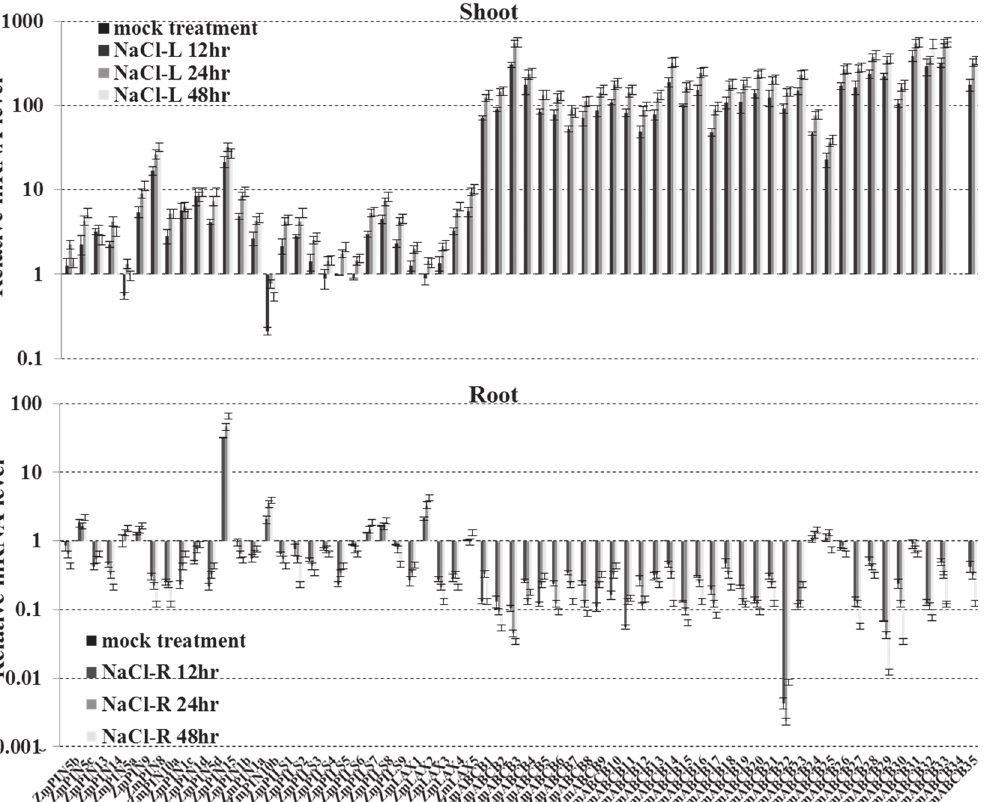
Fig 5. Expression levels of ZmPIN , ZmPILS , ZmLAX and ZmABCB gene families in response to salt. Expression levels of ZmPIN , ZmPILS , ZmLAX and ZmABCB genes were analyzed by qRT-PCR in both shoot (A) and roots (B) of 14-day-old seedlings, which were treated with 150 mM NaCl (salt) for 48 hours. The relative expression levels were normalized to a value of 1 in mock seedlings. Error bars represent SD from five biological replicates.